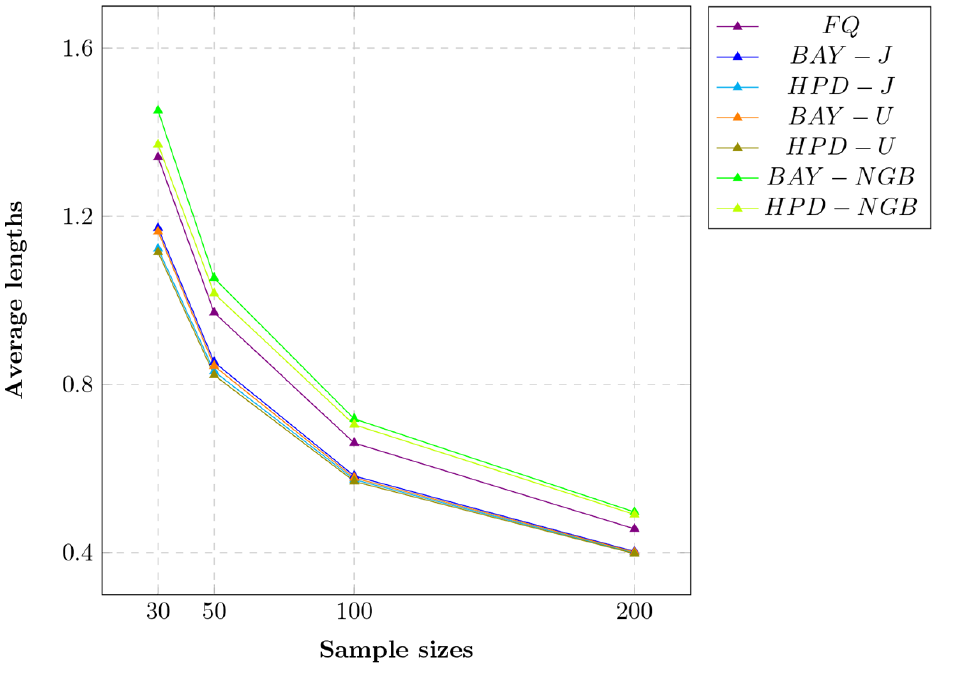
Figure 2. Line graphs of the ALs of the methods in the simulated scenario with different sample